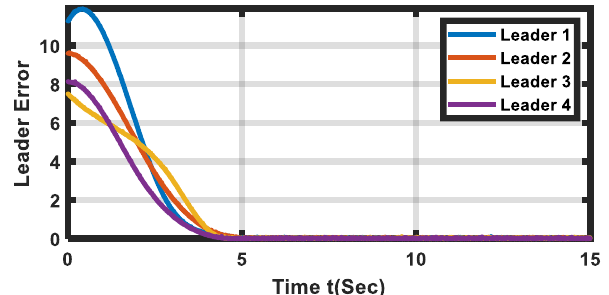
Figure 4. The tracking errors for the leaders.